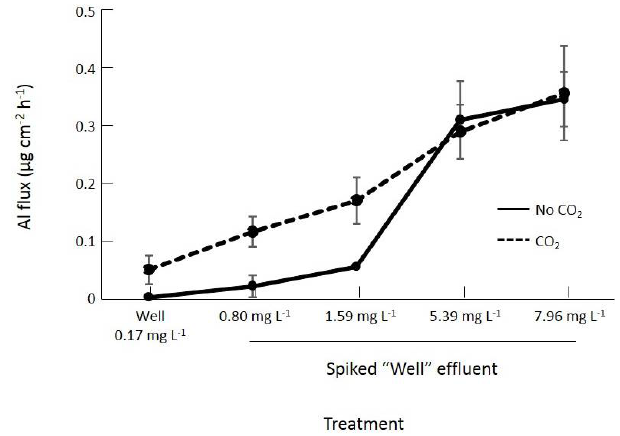
Figure 3. Flux of Al into the diffusive gradient in thin film (DGT) passive sampling devices during the outdoor cultivation experiment using waste water from Giru Drinking Water Treatment Plant (GDWTP) (“Well”) spiked with a range of Al concentrations. The data show flux across a single 7 day deployment conducted in parallel with the algal cultivation. The solid line shows Al flux